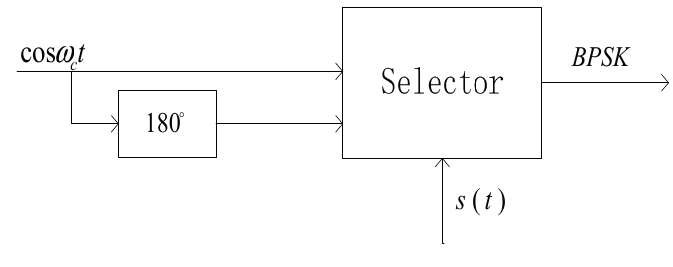
Figure 2. Block diagram of Binary Phase Shift Keying (BPSK)